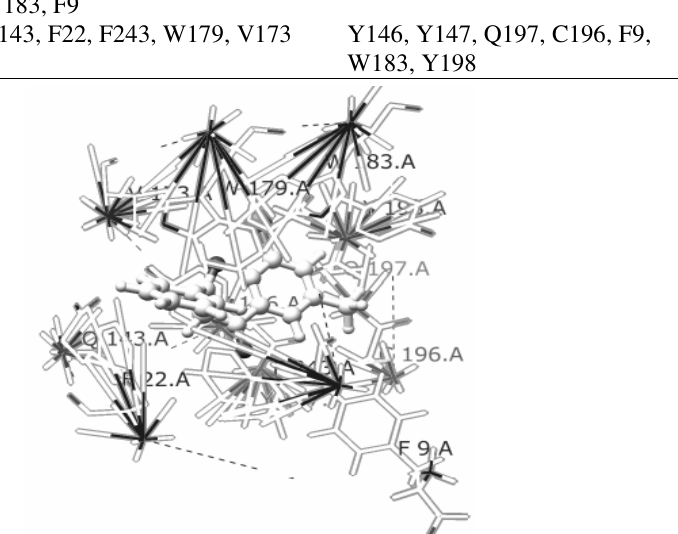
Figure 6. Docked structure of 1c into the active site of